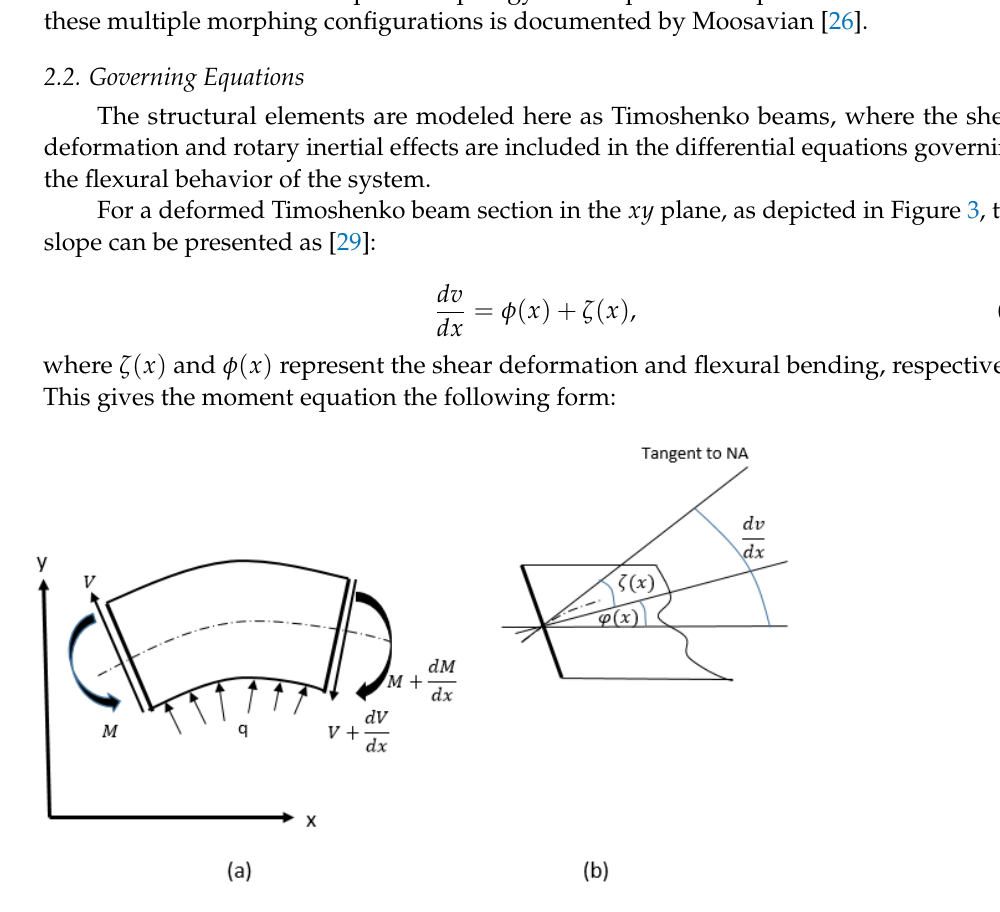
Figure 3. Deformation of Timoshenko beam element under loading; ( a ) deformed beam; ( b ) kinematic details of additional shear